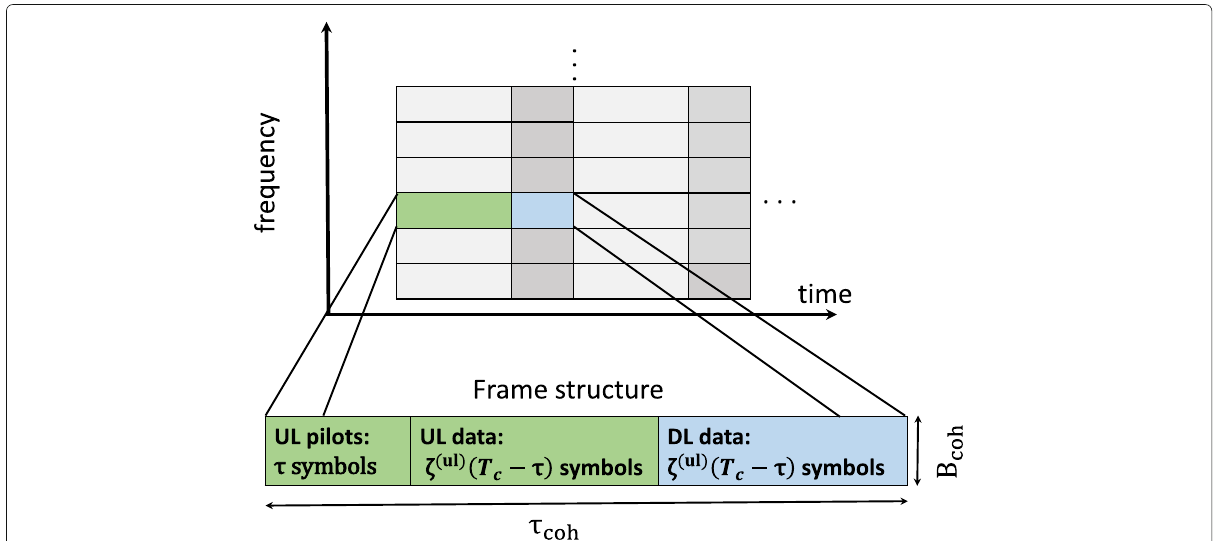
Fig. 2 Massive MIMO frame structure. Transmission consists of coherence length interval of T coh B coh symbols, of which τ symbols are used for pilot signaling and the remaining (τ c − τ) symbols are used for data